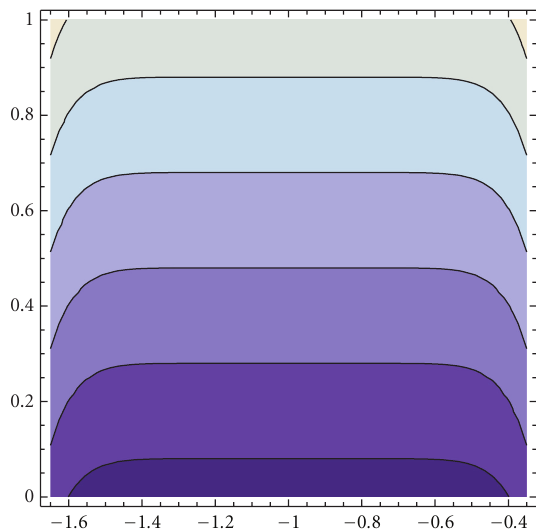
Figure 4: Contour plot of ( ∂ 3 /∂t 3 ) Y 10 (0, r ).